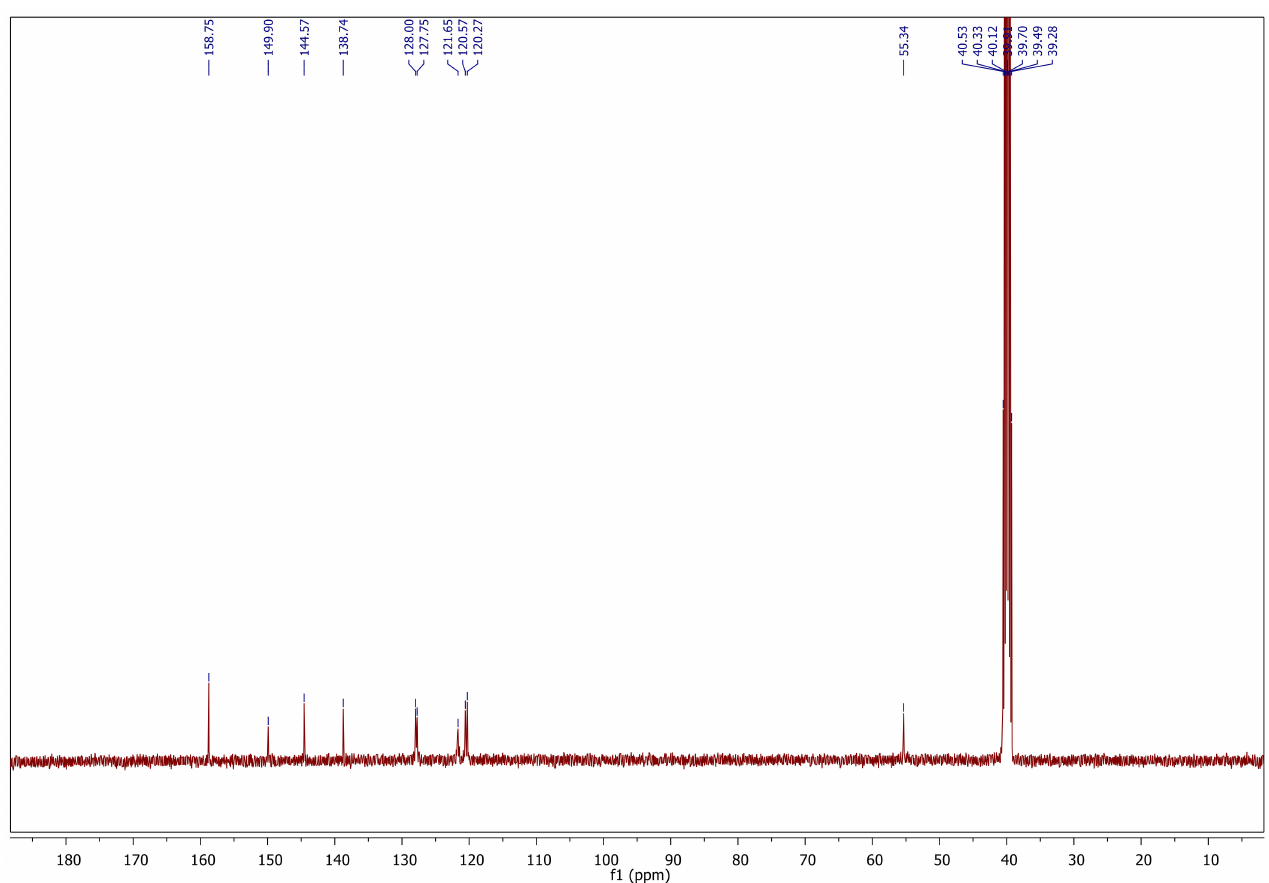
Figure 3. 13 C NMR Spectrum of the 1,2,3-triazole-sulfoamide molecular conjugates 3a .